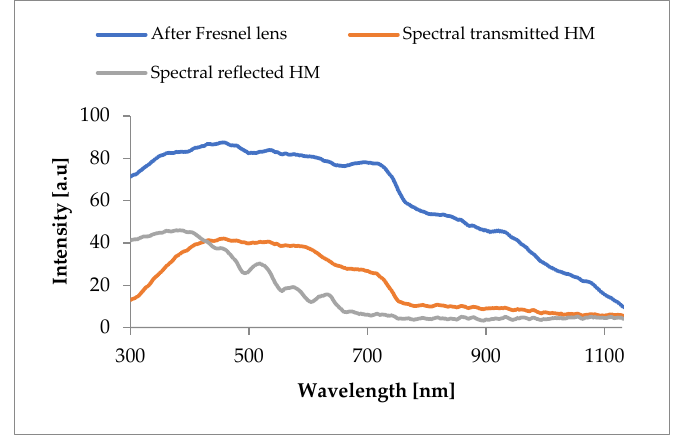
Figure 8. The halogen light spectrum reflected and transmitted by hot mirror.